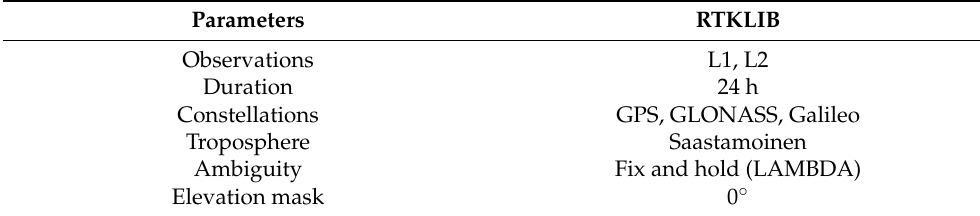
Table 1. The parameters used in the zero baseline test.